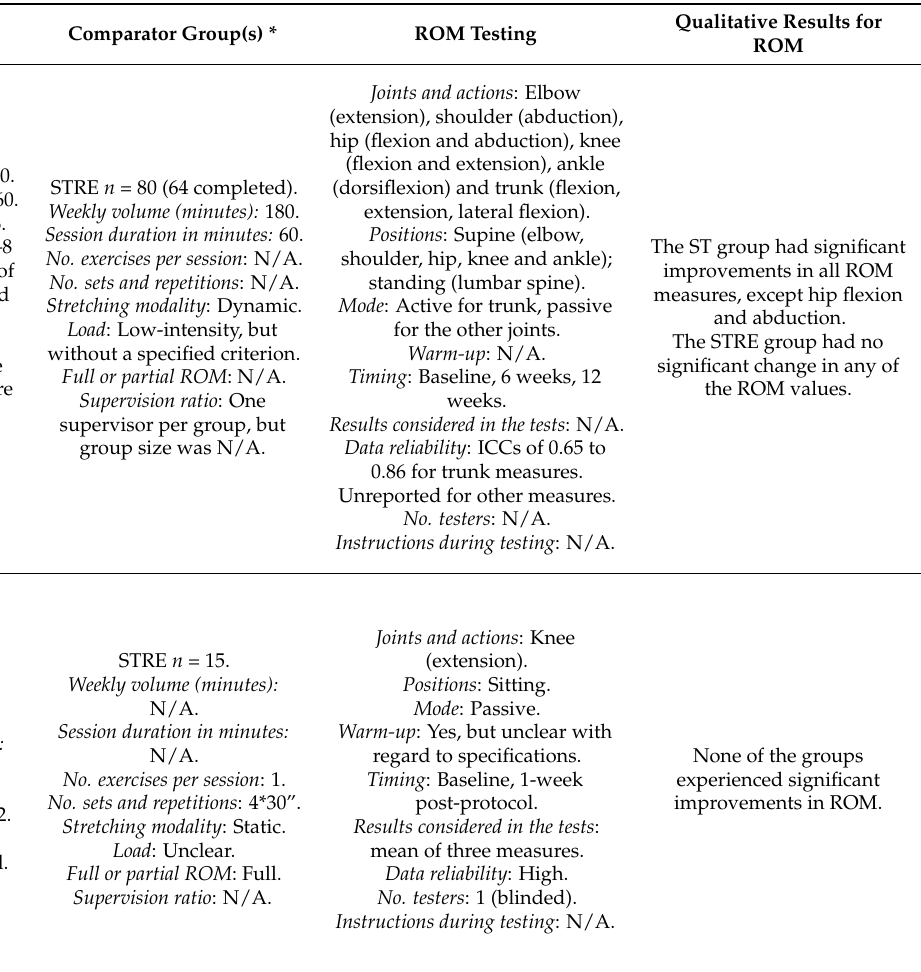
Table 1. Characteristics of included randomized